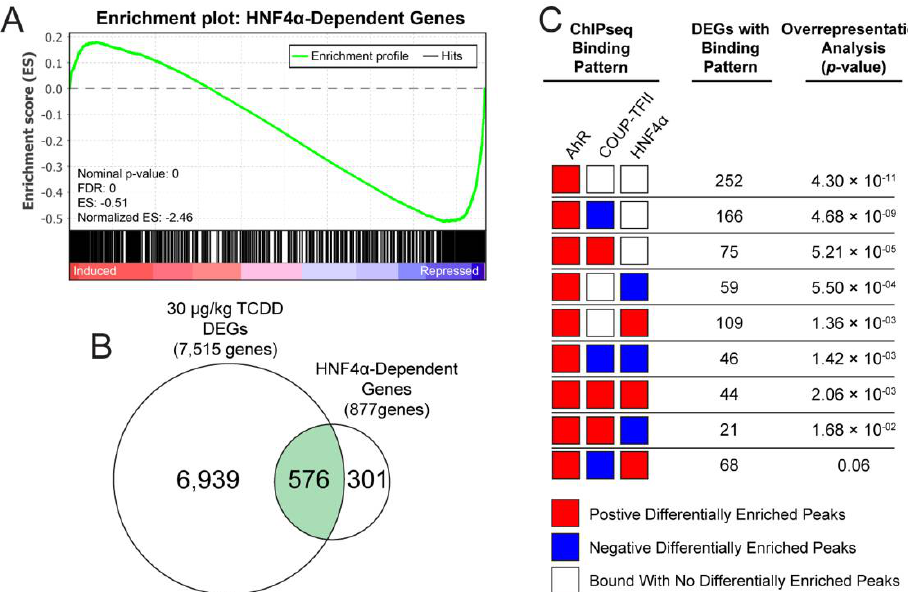
Figure 8. TCDD dose-dependently represses expression of HNF4α-dependent gene expression in the liver. Loss-of-liver function was assessed by examining changes in HNF4α-dependent gene expression. Putative hepatic HNF4α-dependent genes were previously identified [29]. ( A ) Gene set enrichment analysis for HNF4α-dependent genes was conducted using data for C57Bl/6 male mice orally gavaged with 30 ug/kg TCDD every 4 days for 28 days. ( B ) Differential expression was assessed for HNF4α-dependent genes in mice treated with 30 µg/kg TCDD every 4 days for 28 days. ( C ) Over-representation analysis of select transcription factor binding patterns for the 576 hepatic HNF4α-dependent DEGs was performed using a one-sided Fisher’s exact test with FDR correction. Over-representation analysis of all transcription factor binding patterns is available in Supplementary File S3.